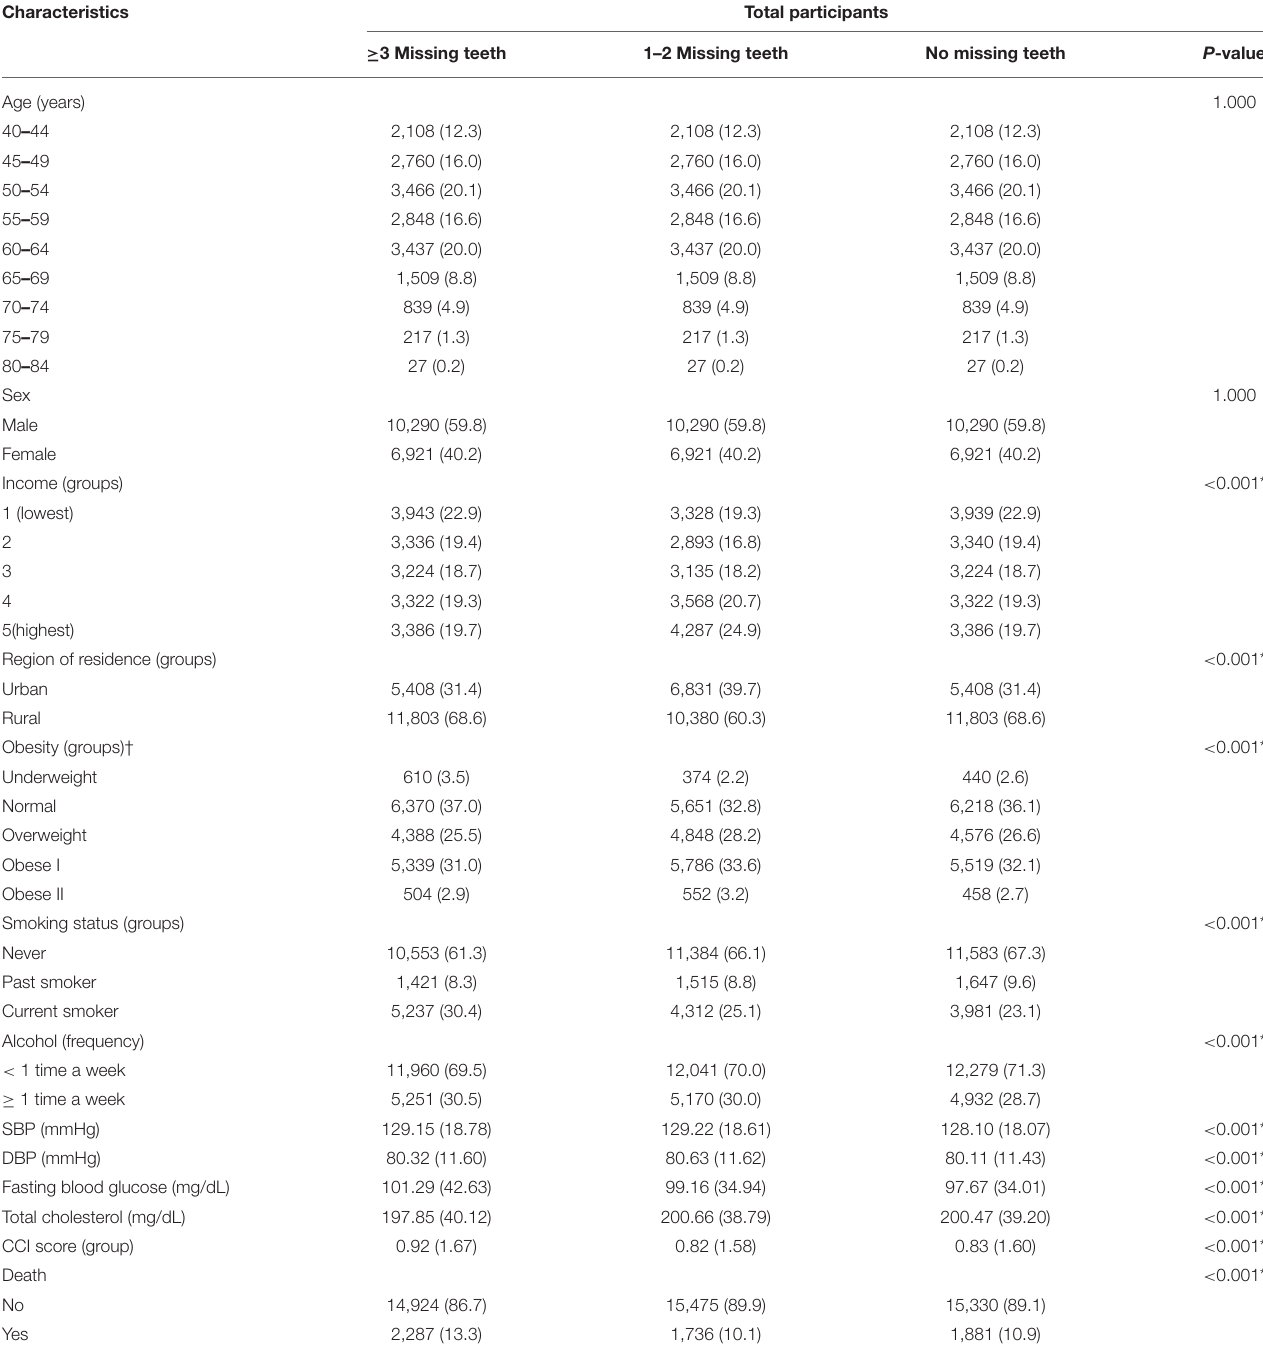
TABLE 1 | General characteristics of